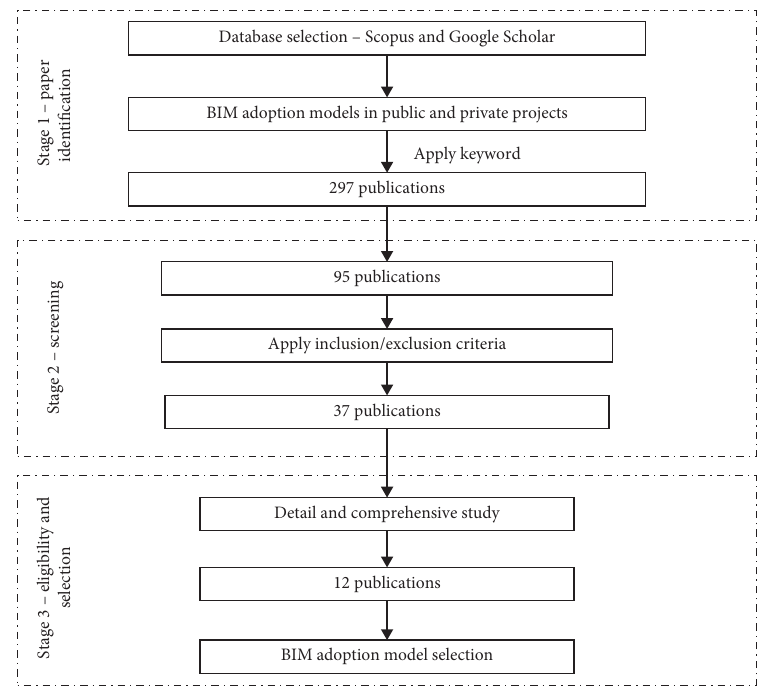
Figure 1: Systematic literature review